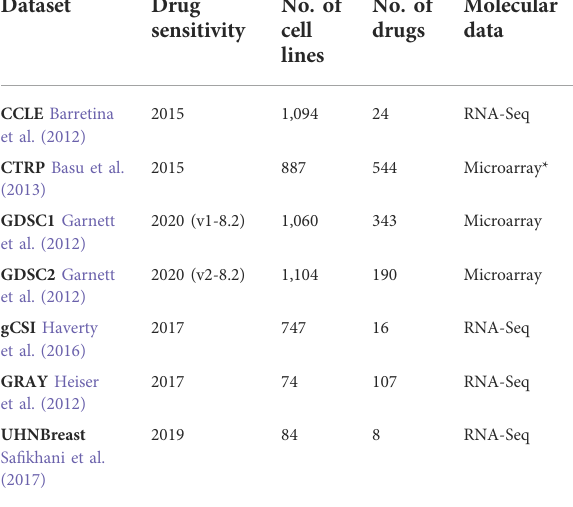
TABLE 1 Studies used in meta-analyses and corresponding drug response versions, number of cell lines, and drugs along with molecular data type. Different versions of GDSC study refer to drug responseassaysalongwithupdatedcelllinesanddrugs.(*)represents theCCLEmicroarraydata.Transcriptomic anddrugresponsedata were obtained from the PharmacoGx R package.